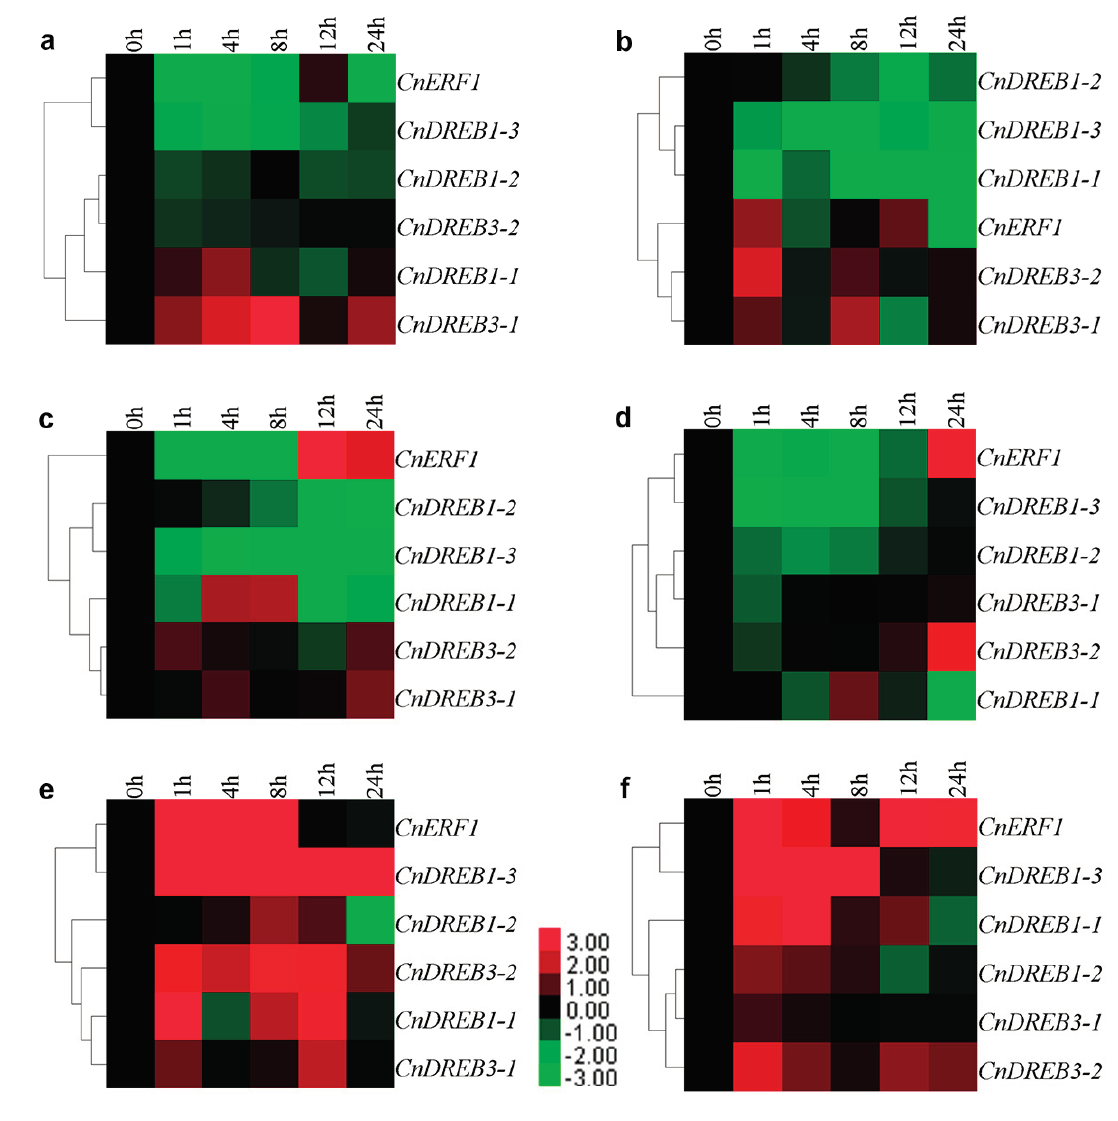
Figure 4. Differential transcript abundance of the CnAP2/ERF TFs in response to ( a ) salinity stress; ( b ) abscisic acid (ABA) treatment; ( c ) salicylic acid (SA) treatment; ( d ) jasmonic acid (JA) treatment; ( e ) low temperature stress; and ( f ) wounding. Green cells indicate suppressed and red ones enhanced levels of transcript abundance compared to the relevant control. Black cells represent no significant change of transcript